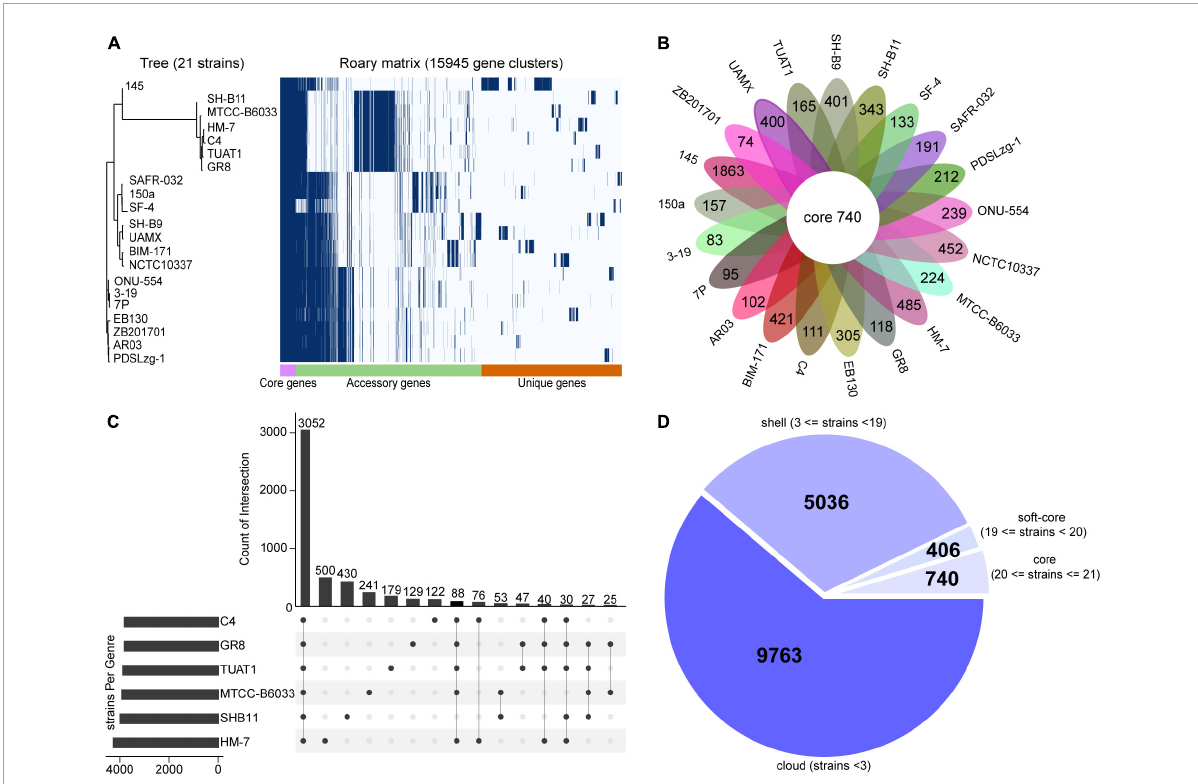
FIGURE3 Pan-core genome analysis of 21 strains of B. pumilus . (A) Gene distribution of 21 B. pumilus strains based on the gene presence–absence matrix generated from Roary. A purple box, a green box, and an orange box to represent the core gene, accessory genes and specific genes, respectively. The phylogenetic tree on the left represents the phylogenetic relationships among the strains involved in the corresponding pan-genome. (B) Flower petal plot of 21 strains. Pan-genome analysis of 21 strains yielded unique genes for each strain, the numbers of which are shown on each petal plot. The center Circos shows that the number of core gene obtained from 21 strains with hard core threshold. (C) Upset plot show the gene set derived from the six strains. Bar numbers are sorted in descending order. Each bar represents the corresponding overlap core genes between two strains. Information provided on the left represent corresponding strain set. (D) Pie plot of 21 strains. Pan-genome analysis of 21 strains yielded accessory genes, including shell and cloud